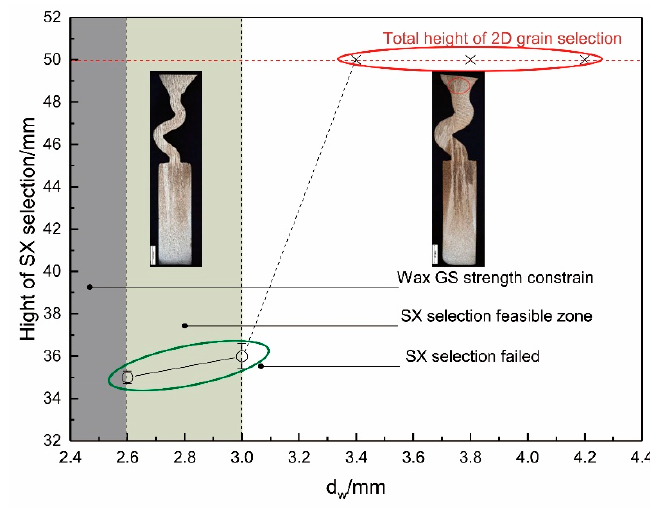
Figure 4. Experimentally observed heights of single crystal (SX) position versus selector thickness (d w ).